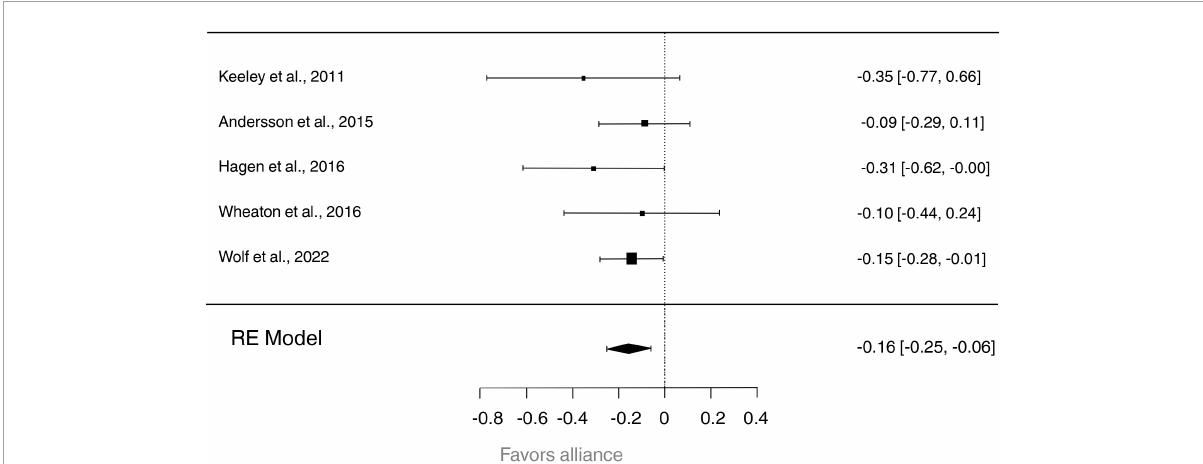
FIGURE2 Forest plot visualizing the relationship between the global therapeutic alliance and the treatment outcome for each included study. Horizontal bars show 99% confidence intervals, with the study having a significant effect denoted by horizontal bars that do not touch the dotted vertical line (the line of no effect). Diamonds sizes reflect the weight of the overall study.